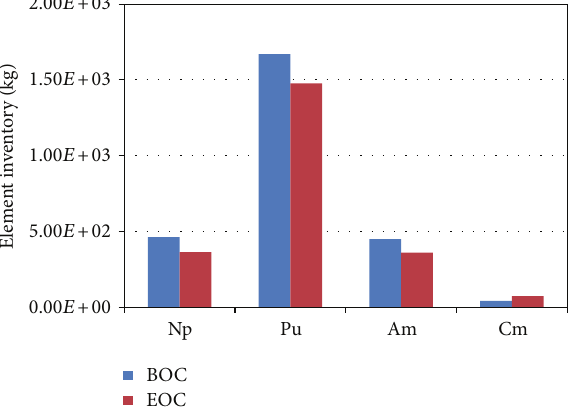
Figure 3: Isotopic inventory for 40 GWd/t fuel